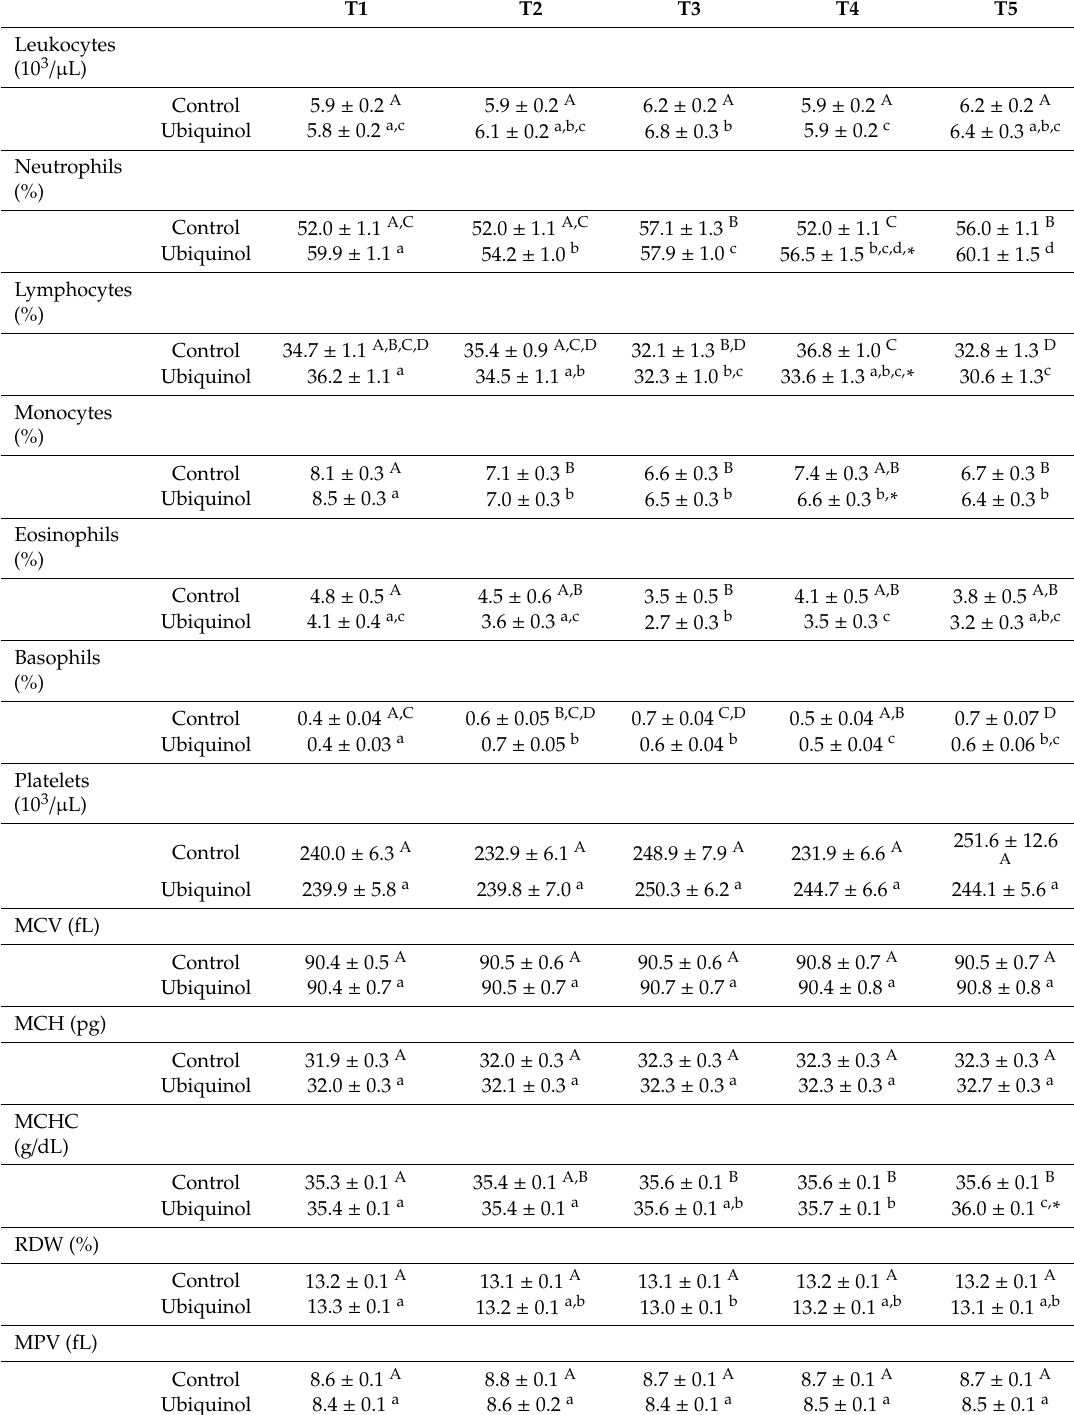
Table 2. E ff ects of exercise and ubiquinol supplementation on hematological parameters. Results are expressed as mean ± SEM. * means statistically significant di ff erences between groups ( p < 0.05). T1: Before supplementation (basal value); T2: After supplementation (two weeks) and before the first physical test; T3: After first physical exercise test; T4: After 24 h of rest and before the second physical test; T5: After second physical exercise test. Di ff erent letters in every group indicates